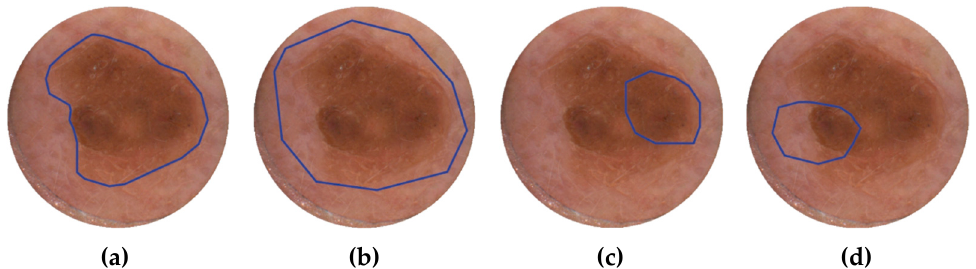
Figure 5. The ROI normalization principle. Four different scenarios in the clinical routine: ( a ) The region of interest (lesion boundaries) matches the area of measurement chosen by the DermaFC operator; no correction factors are used. ( b ) The whole lesion is measured together with the surrounding skin outside the tumor. ( c ) The fraction of the lesion and no healthy skin is measured. ( d ) Both factors are used for normalization of ROI, as the lesion is not completely measured, and a significant part of the scan area covers the skin around the tumor.